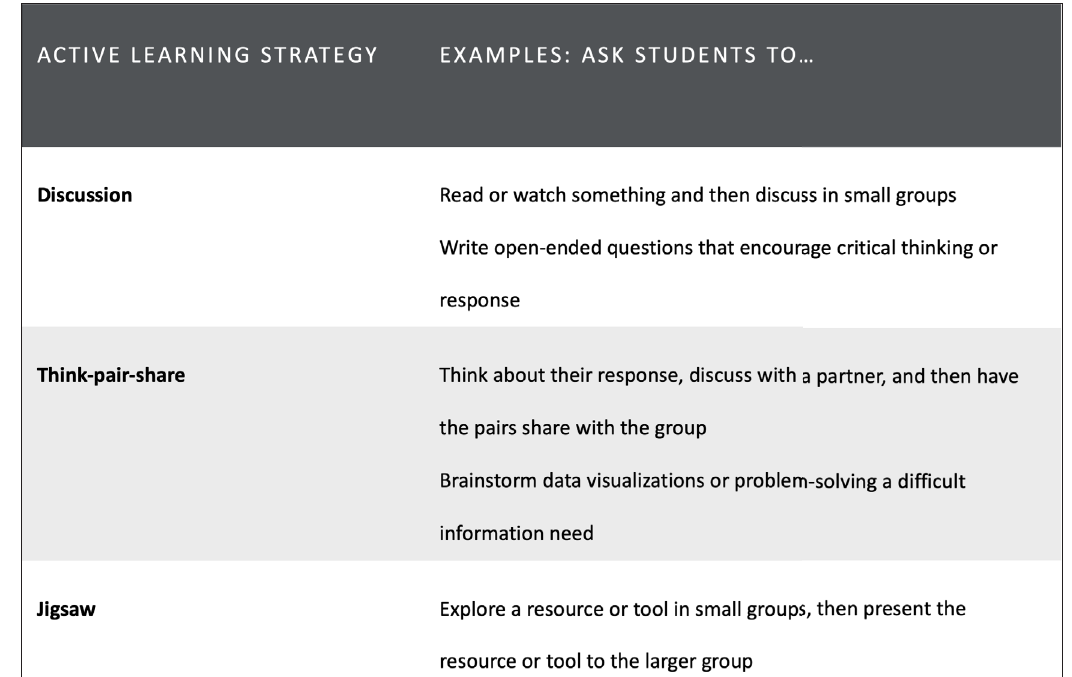
Figure 2 : Active learning